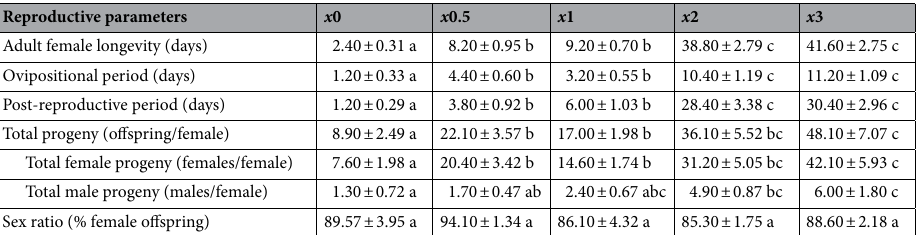
Table 1. Reproductive parameters (mean ± SE) of Hadronotus pennsylvanicus reared on Leptoglossus zonatus eggs every other day at 25 °C ± 1, 75 ± 5% RH and 16:8 L:D, fed a honey-water diet once (× 1), twice (× 2), three times (× 3) per week, once every other week (× 0.5), or fed a water diet (× 0). Parameters with different letters indicate significant differences across the different treatments ( P < 0.05; GLM and Tukey post hoc